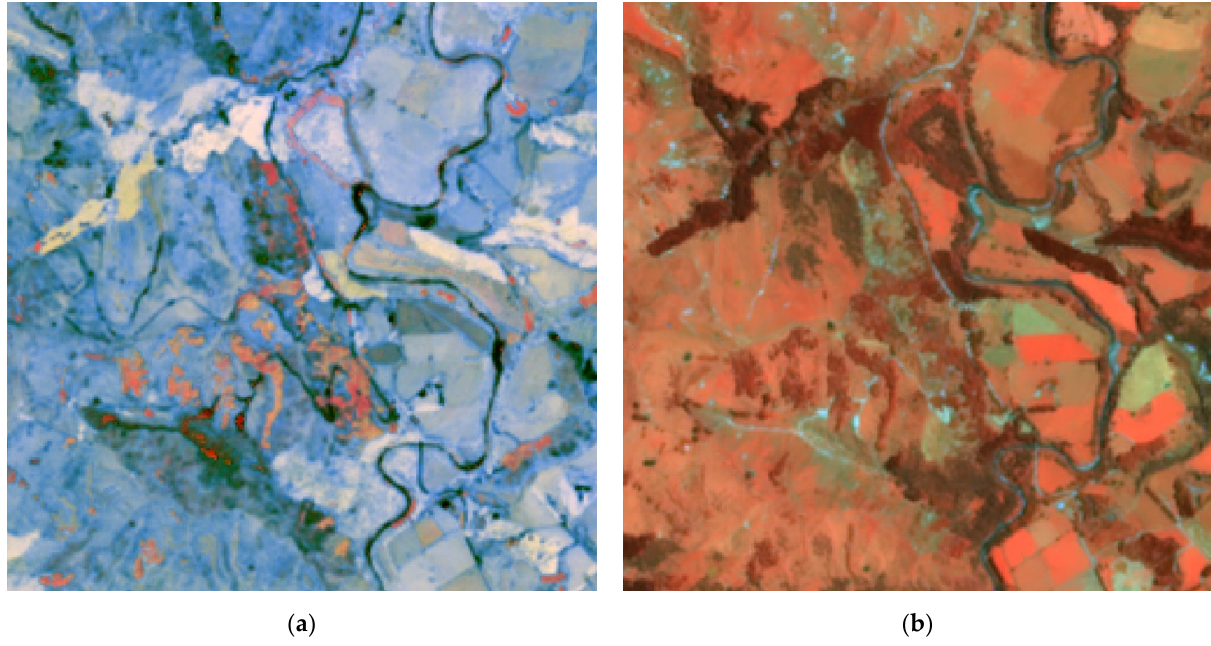
Figure 14. ( a ) A map of Wairarapa highlighting differences in median NDVI response of indigenous evergreen forests (in white) and exotic deciduous forests (in red); ( b ) the same area with a topographically flattened summer mosaic.